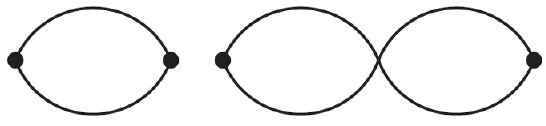
Figure 3 . The (cid:30) 2 (cid:0) (cid:30) 2 correlator up to order ^ g